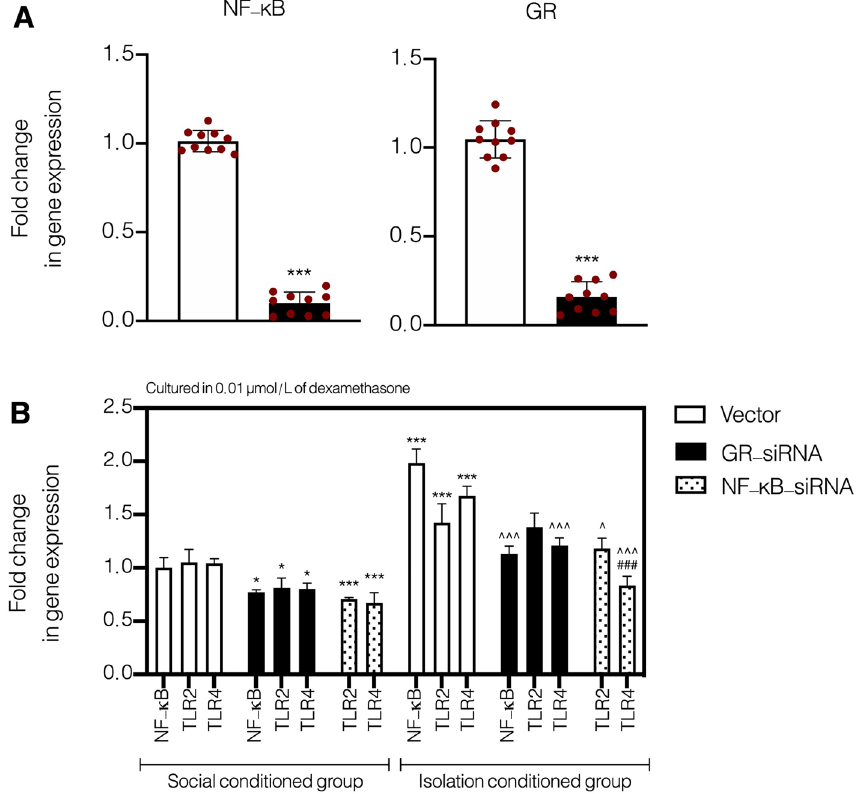
Figure 1. Fold change in gene expression of TLR2, TLR4, and NF-κB in GR- and NF-κB- (p50 subunit) knock- down cultured monocytes derived from bone marrow of socially isolated animals. Values are expressed as the mean ± S.E.M. (n = 10 in each group) results were analyzed using One-Way ANOVA followed by Tukey’s post hoc test. *** P < 0.001 compared to social condition group treated with vector. ### P < 0.001 compared to isolated condition group treated with GR-siRNA, ∧ P < 0.05 and ∧∧∧ P < 0.001 compared to social isolation group treated with